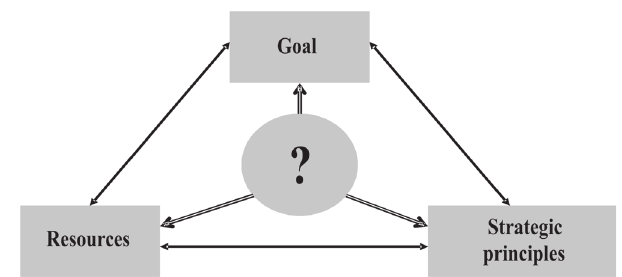
Fig 1 . Necessary unity of goal, resources and strategic